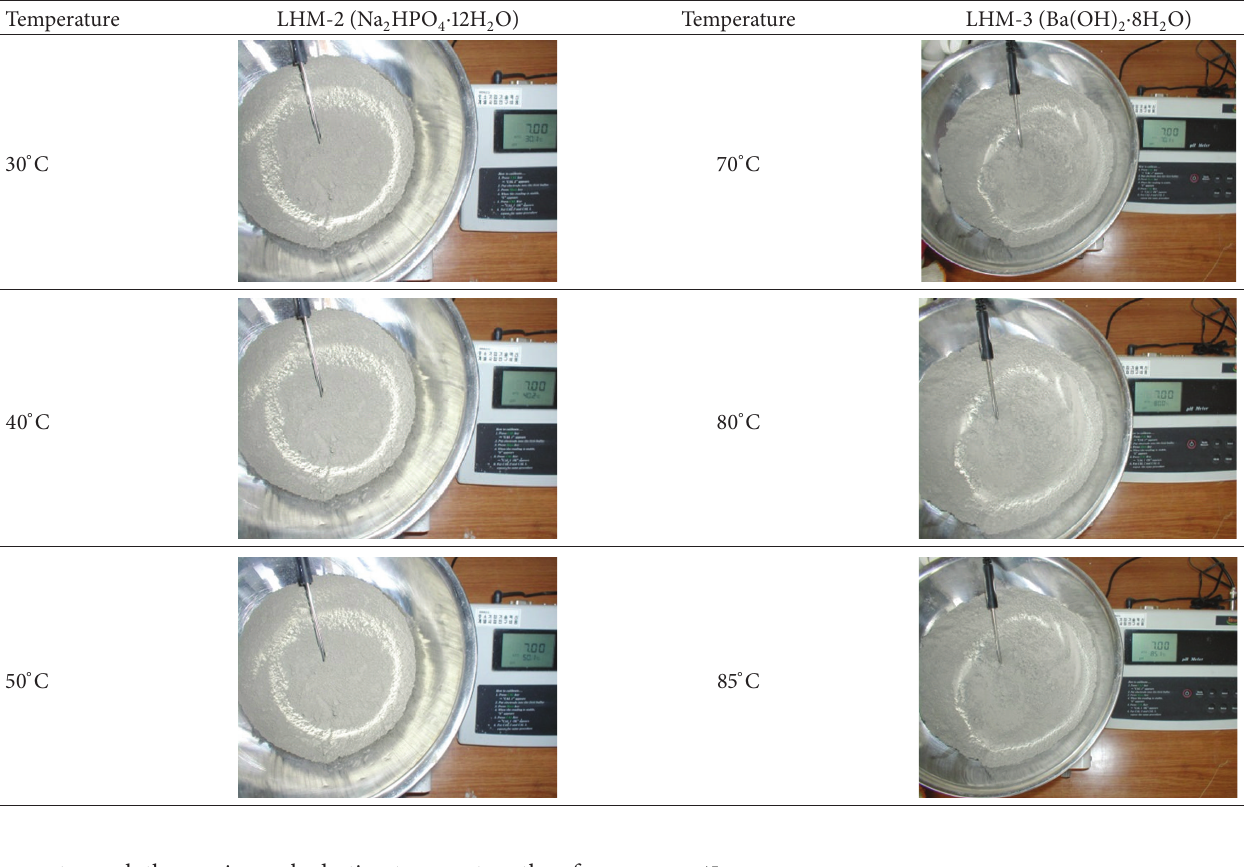
Table 4: Test results of thermal stability in LHM-2 and LHM-3.